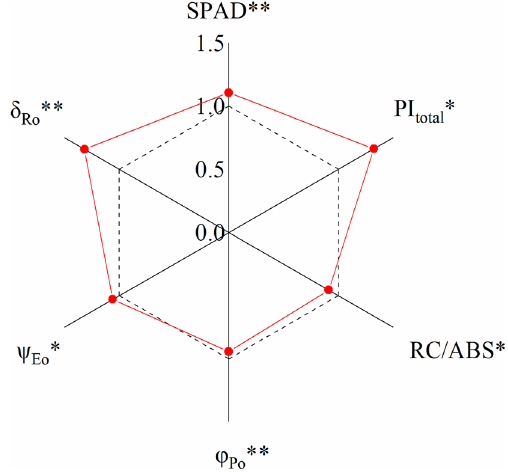
Figure 7. Ratio of the parameter mean value of Sanjiao test site to Yangqu test site. *The parameter is observed significant differences between Yangqu test site and Sanjiao test site at the 0.05 level. **Significant differences at the 0.01 level. The dotted lines indicate the 1.0×.